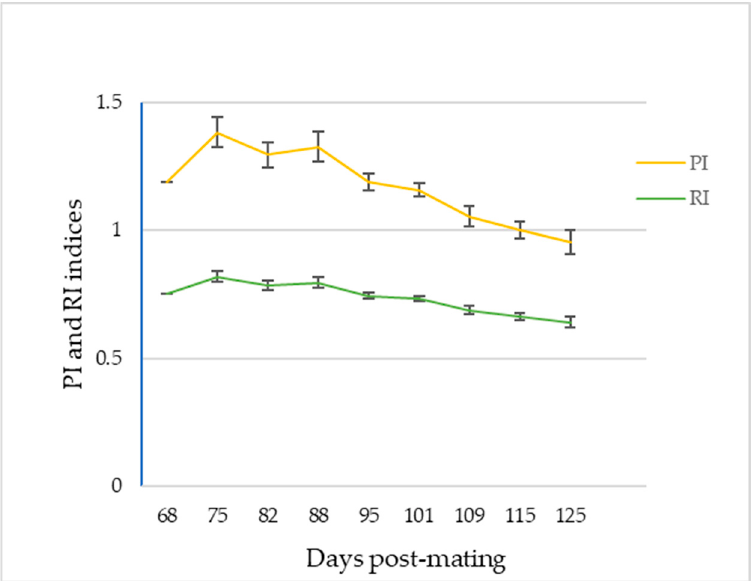
Figure 7. Evolution curves of Pulsatility Index (PI) and Resistance Index (RI) in total goats under study ( n : 9). The mean and the standard deviation of the measurements are plotted in relation to the days after mating. days after